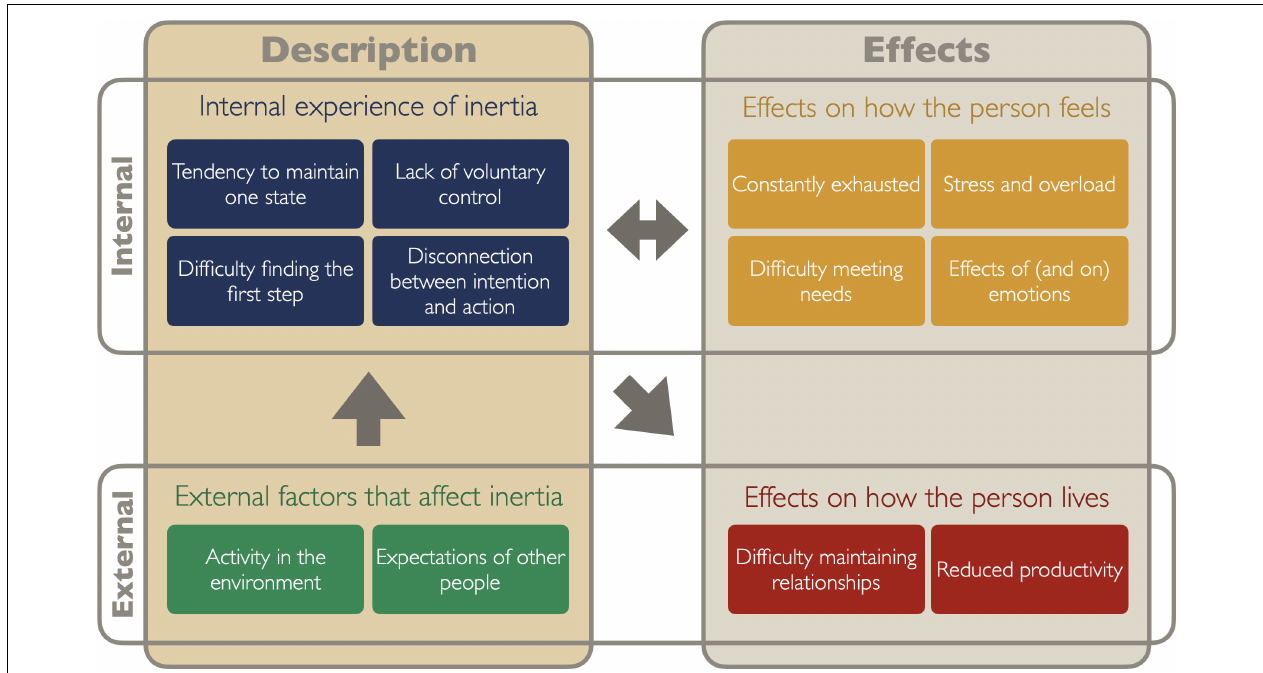
FIGURE 1 | Diagram of themes in autistic inertia. Themes (colored rectangles) are organized into primary categories (columns) of ‘Description’ and ‘Effects.’ These are further divided into internal and external domains. This then provides four sub-categories: internal experiences of inertia (blue), external factors that inhibit or facilitate action (green), effects on how the person feels (yellow), and effects on how the person lives (red). Arrows indicate the direction of effects as one area influences another.